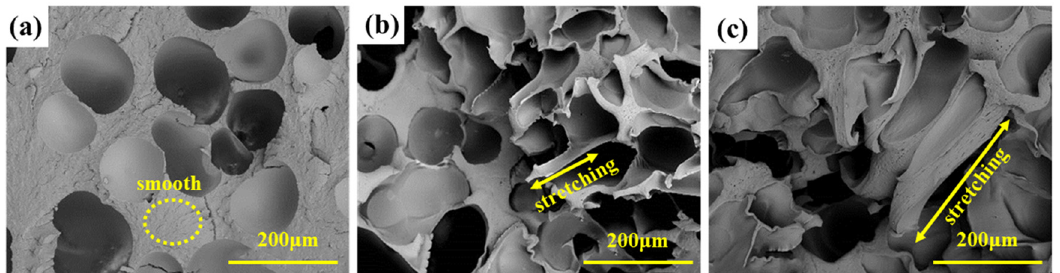
Figure A4: Impact fracture surfaces of ( a ) pure PA6, ( b ) PA6 - ZeMac 0.5, and ( c ) PA6 - TGIC 0.5.